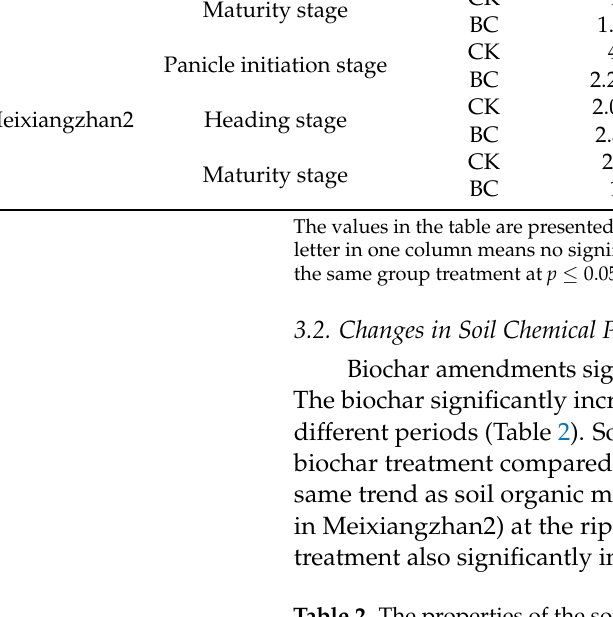
Table 2. The properties of the soil in different periods by biochar